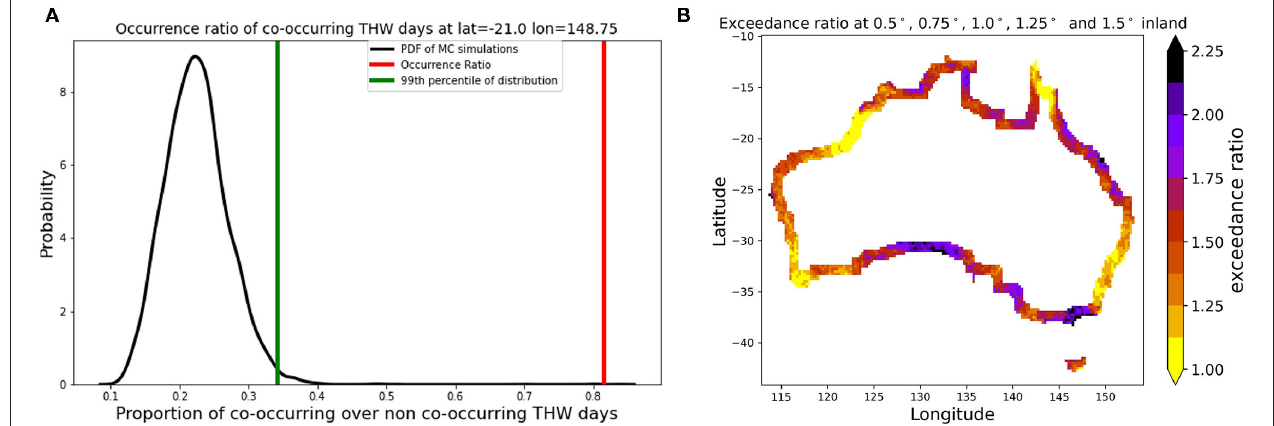
FIGURE 5 | (A) Occurrence ratio and the associated randomized (Monte Carlo) PDF and 99th percentile of the distribution of co-occurring events at 21.00 ◦ S 148.75 ◦ E (GBR region). (B) Exceedance ratio (i.e., ratio between occurrence ratio and 99th percentile of Monte Carlo simulations) for all coastal/adjacent ocean cell pairs around Australia. The ratios are calculated for pairs of adjacent cells 0.5 ◦ inland, 0.75 ◦ inland, 1.0 ◦ inland, 1.25 ◦ inland, and 1.5 ◦